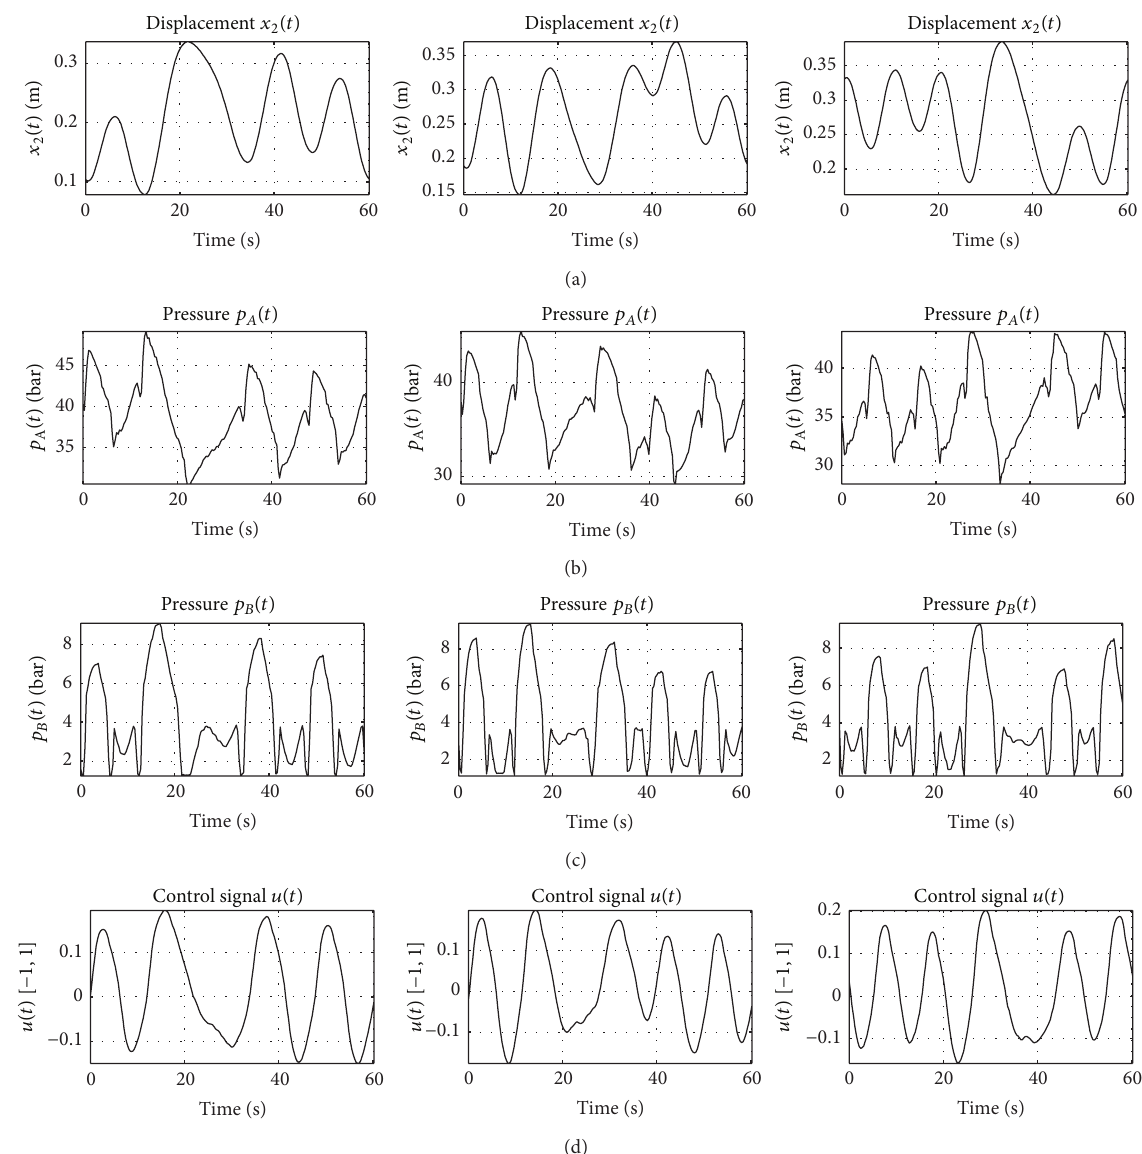
Figure 8: Each column depicts a different recorded capture used for identification. (a) Cylinder displacement 𝑥 2 (𝑡) in meters. (b) Pressure (𝑡) in chamber 𝐴 in bars. (c) Pressure 𝑝 (𝑡) in chamber 𝐵 in bars. (d) Control input 𝑢(𝑡) . All data is presented for a period of 60 𝑝 𝐴 𝐵